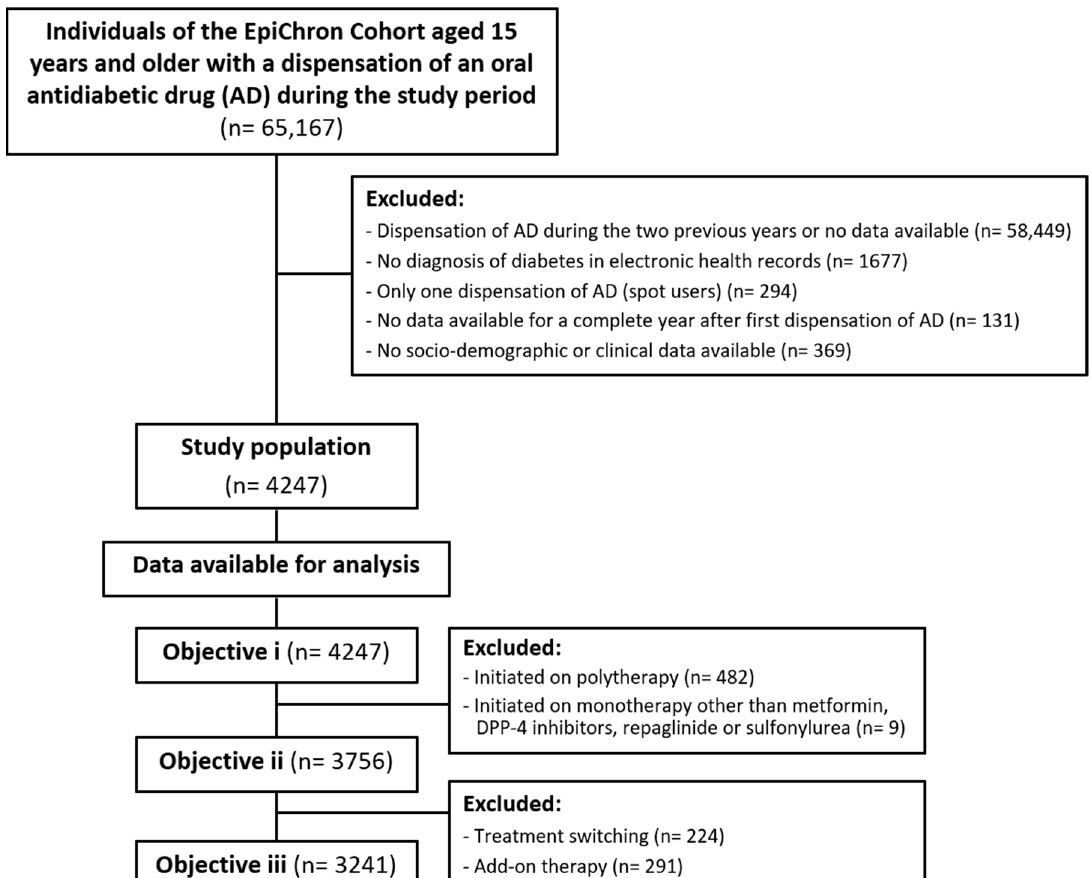
Figure 1. Flow chart of the study population.